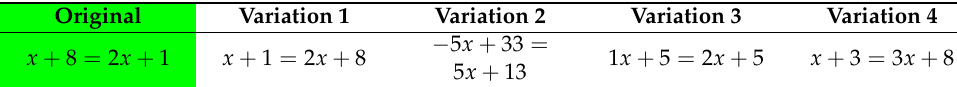
Table 13. Examples of type 11 equations and variations with a < c .